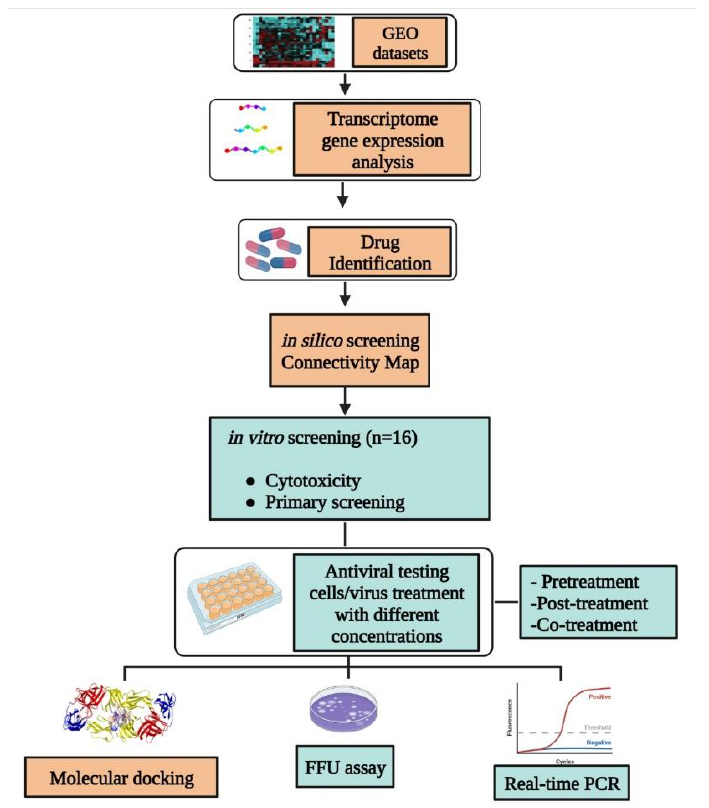
Figure 1. In silico and in vitro methods used for selecting and studying the antiviral activity of drugs for repurposing.